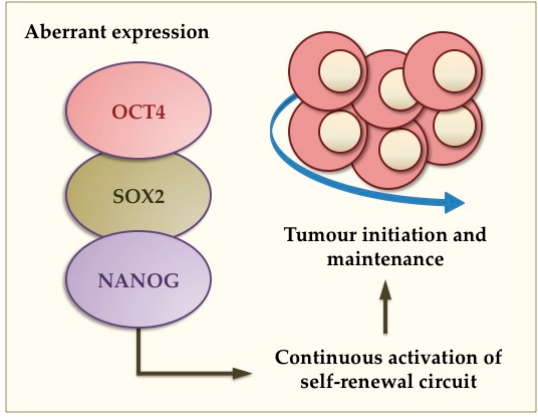
Figure 2. Proposed function of pluripotency TFs in brain and breast malignancies. The cancer stem cell (CSC) theory implicates that CSCs can express pluripotency genes such as OCT4 , SOX2 and NANOG . Aberrant expression of such genes causes continuous activation of the self-renewal circuit leading to oncogenic transformation, tumour initiation and maintenance.